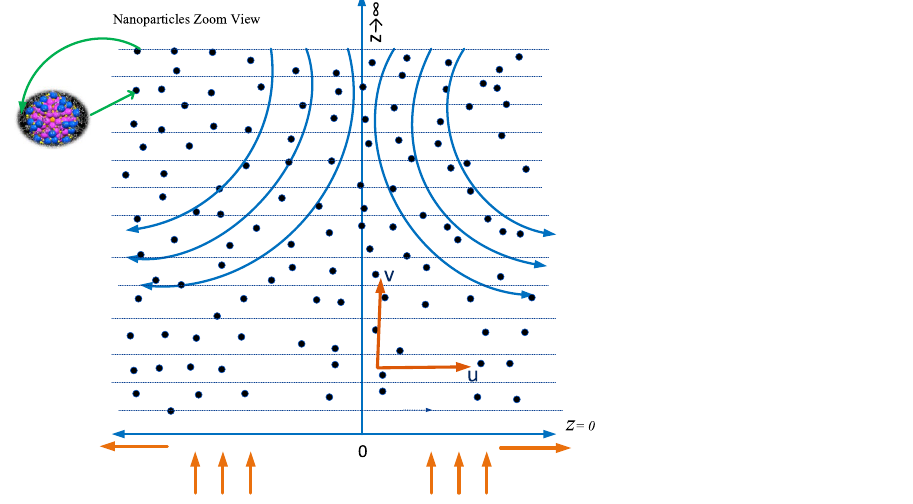
Figure 1. Physical geometry of the proposed